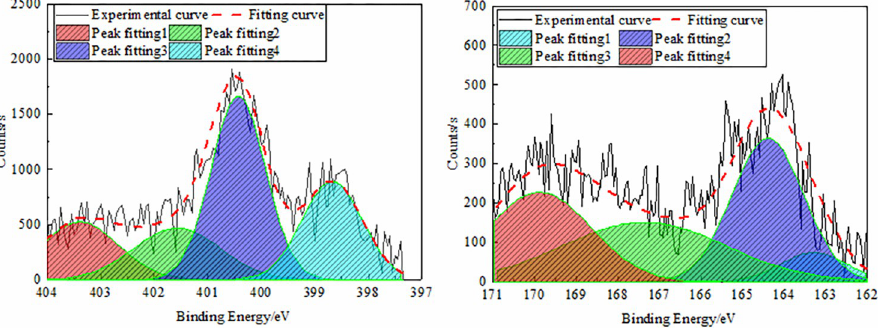
Fig 7. Peak fitting spectra of nitrogen and sulfur in anthracite. (a) Nitrogen, (b) Sulfur.